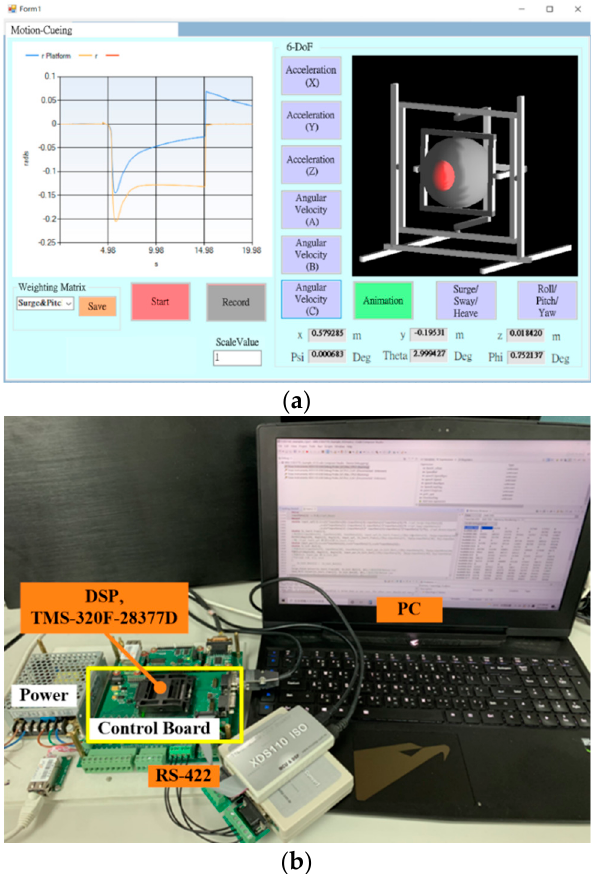
Figure 7. Hardware − in − the − loop (HIL) simulation platform: ( a ) user interface; ( b ) test bench.